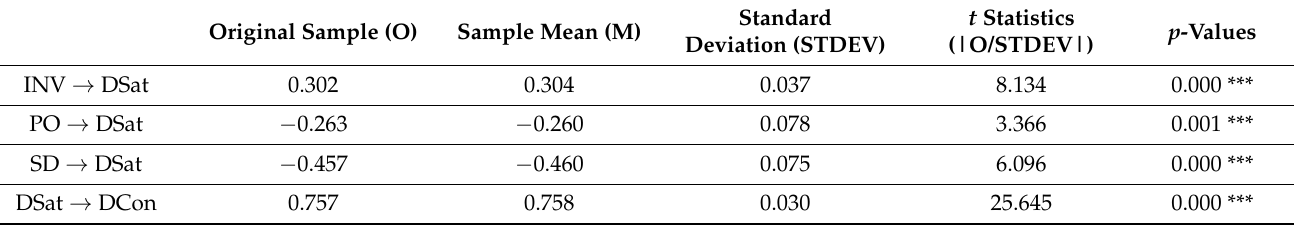
Table 6. Path coefficients of the model.